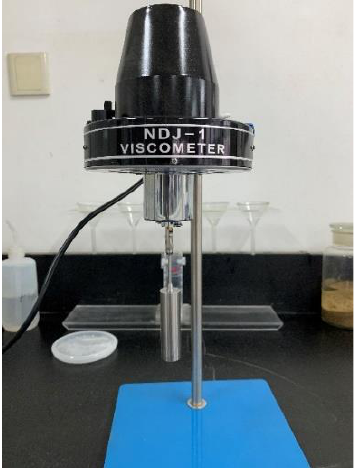
Figure 2. Pointer rotary viscometer NDJ-1.